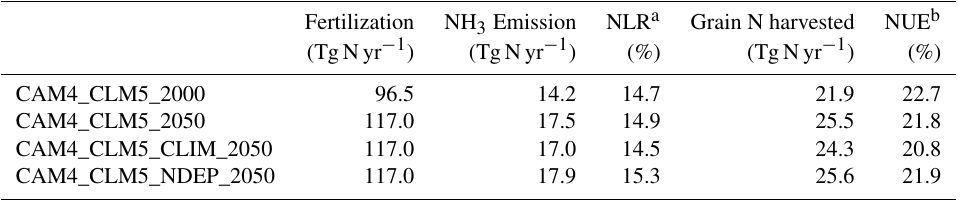
Table 4. Summary of N fluxes in the simulations averaged over 20 years.